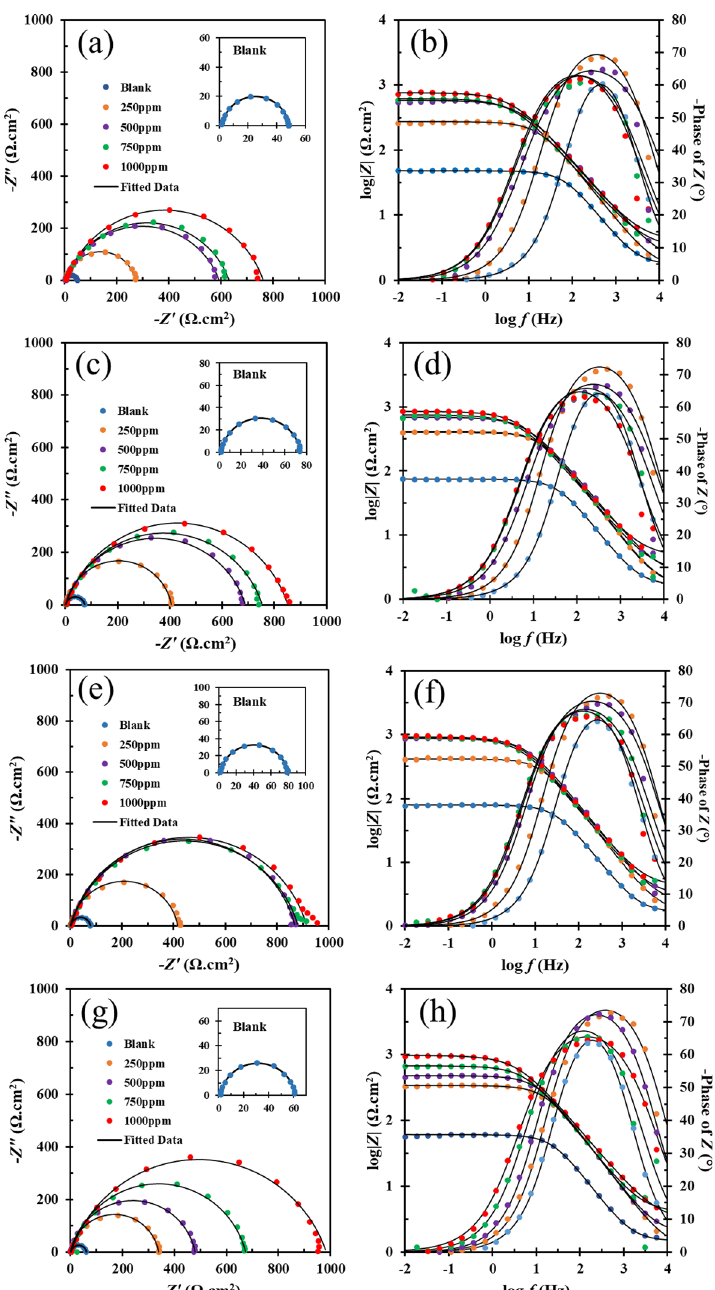
Figure 2. Nyquist (left) and Bode (right) diagrams for prepared samples after 1 h ( a , b ), 3 h ( c , d ), 6 h ( e , f ) and 24 h ( g , h ) immersion in 1 M HCl solution containing various concentration of DPH at room